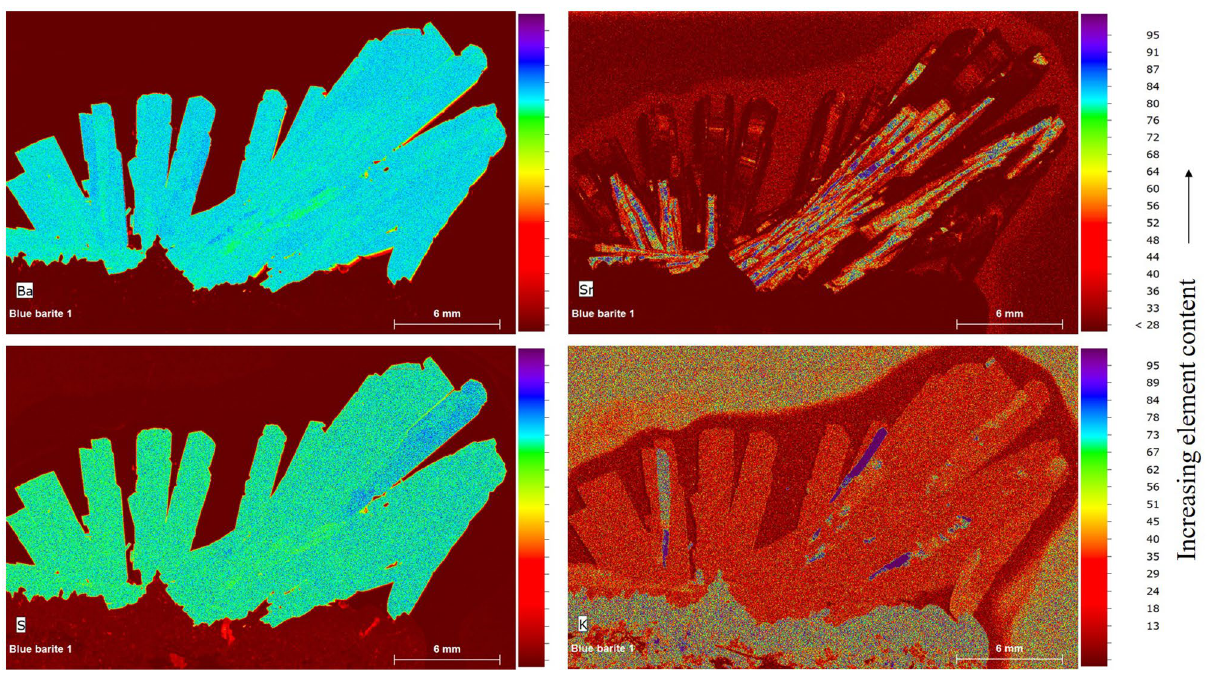
Figure 7. False-colour elemental distribution maps for Ba, S, Sr, and K obtained by the Energy-dispersive μX-ray Fluorescence Spectrometry of barite crystals (polished